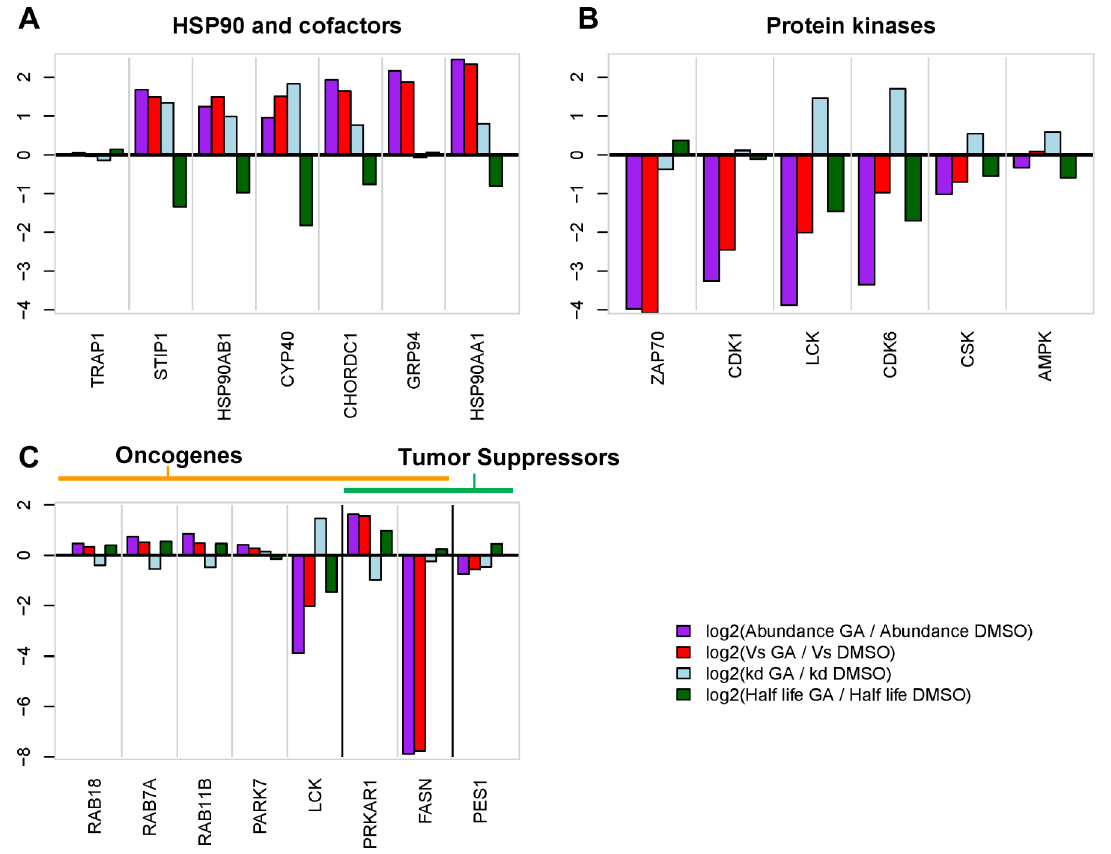
Figure 7 . Relative changes in kinetic parameters upon GA treatment. Relative changes in synthesis (log 2 [V s_GA /V s_DMSO ]), decay (log 2 [k d_GA / k d_DMSO ]), abundance (log 2 [p GA /p DMSO ]), and half-life, (log 2 [T 1/2_GA /T 1/2_DMSO ]) for selected proteins are represented in the respective plots according to the bar colour codes. Proteins were selected from the following categories: A ) Hsp90 and cofactors B ) Protein kinases and C ) Tumour suppressors and oncogenes. As for Figure 6, all values are adjusted by the median of the entire proteome. PRKAR1 and FASN are annotated as both possible oncogenes and tumor suppressors [73].